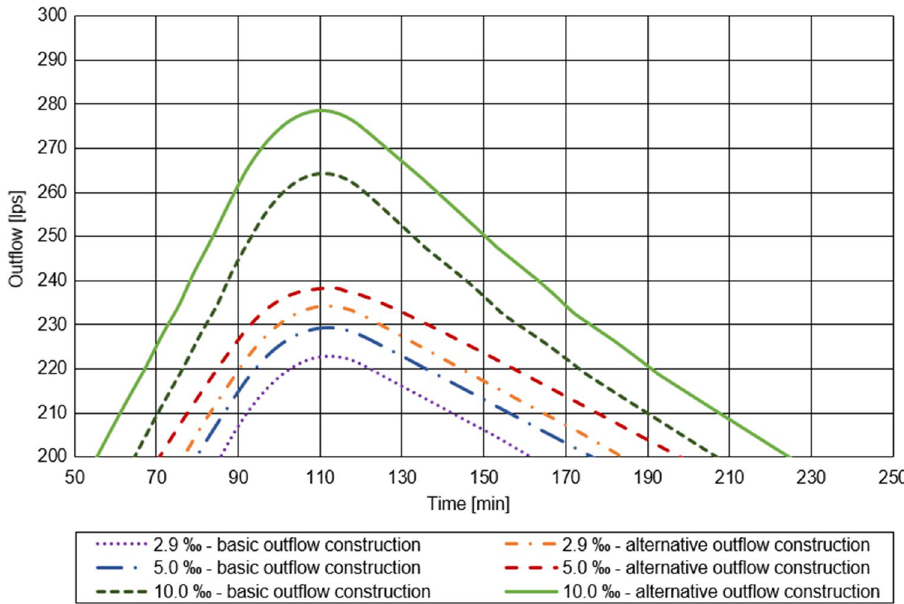
Fig. 9 Impact of vertical posi‑ tion of outflow from the tank on outflow rates in time, for the surface area of the tank bottom 2 and for the storm A zb = 2500 m duration equals to 3∙ t dd